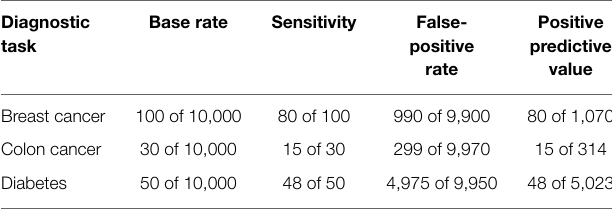
TABLE 1 | Information about prevalence of the diseases, and sensitivity and false-positive rate of the